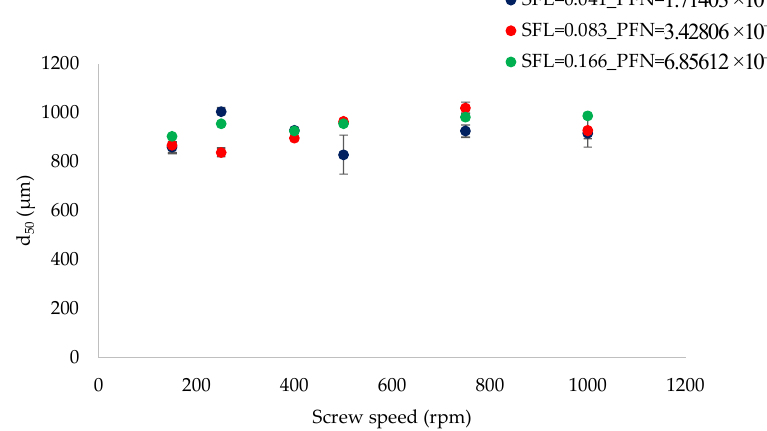
Figure 5. Median granule size of lactose at different SFL–PFN at varying screw speed (L/S 0.1). Figures 6 and 7 show the size distribution of granules produced at varying SFL–PFN at L/S of 0.048 and 0.1, respectively. The size distribution results support the median granule size data obtained at respective L/S.